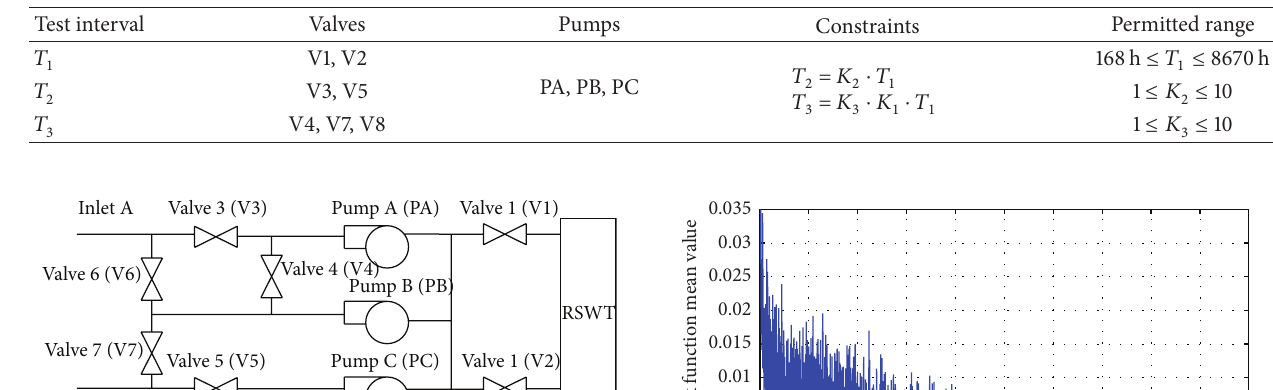
Table 6: Constraints on test intervals (TI).